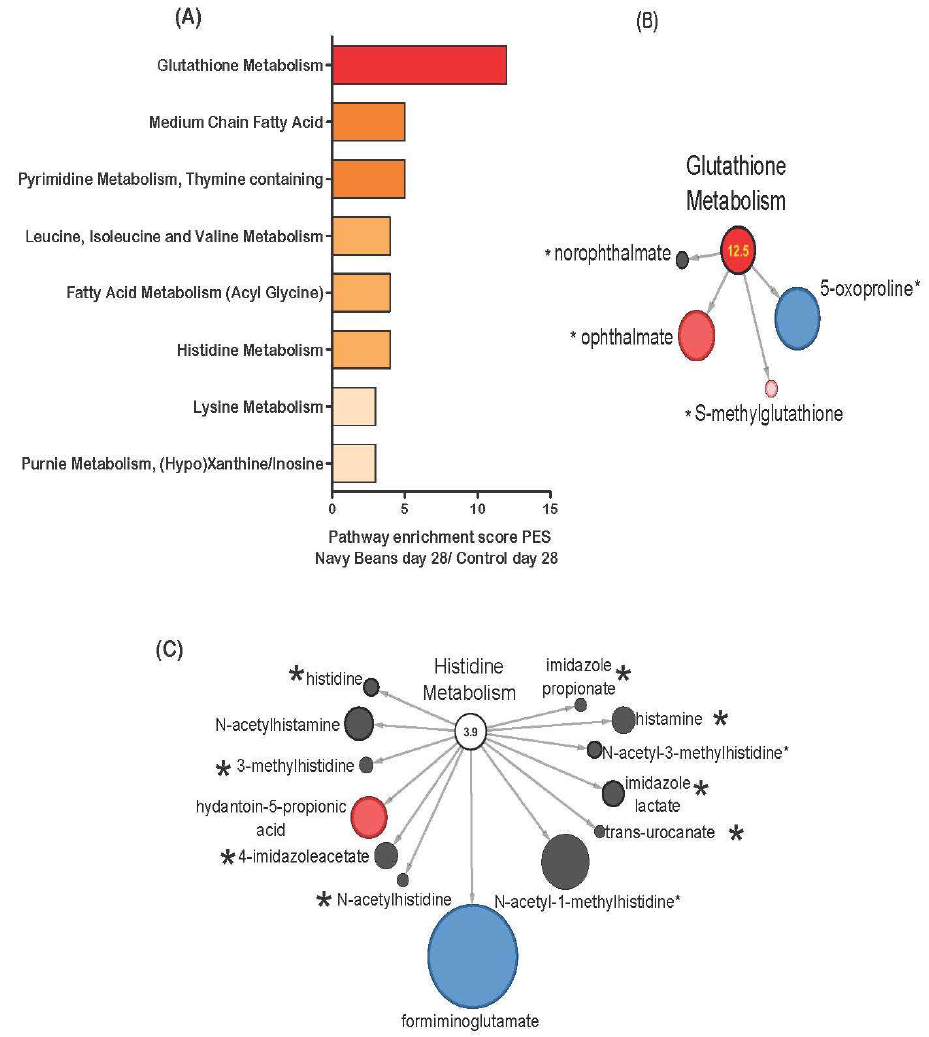
Figure 3. Stool metabolic pathways impacted by navy beans consumption as measured by pathway enrichment score (PES) and compared to control at day 28. ( A ) All metabolic pathways with a PES > 2.0, ( B ) glutathione metabolism (4 identified navy bean metabolites) PES 12.5, and ( C ) histidine metabolism (8 identified navy bean metabolites) PES 3.9. Red nodes indicate significant increase, blue node is significant decrease, and light pink shows trending increase in abundance between navy beans and control group at 28 days. The size of the circle reflects the relative abundance when scaled to all stool metabolites. The * indicates presence in the navy bean metabolome listed in Supplementary Table S1.